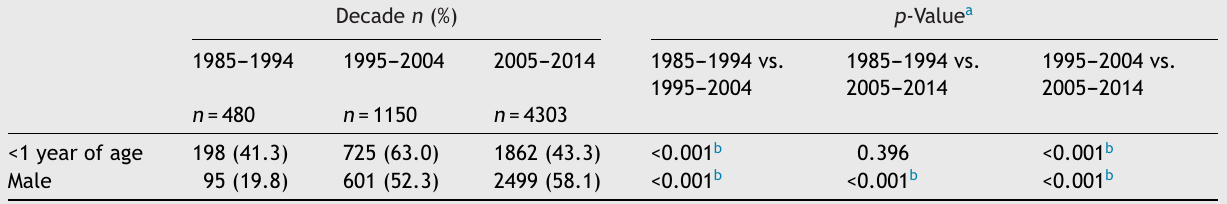
Epidemiological data on children who have received a tracheostomy between 1985 and 1994, between 1995 and 2004, and between 2005 and